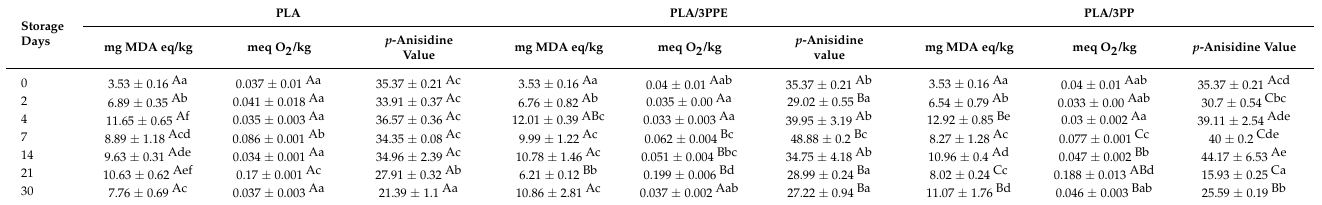
Table 7. Results of the TBARS assay, determination of the peroxide value, and the p -anisidine value of the almonds packaged with control and active PLA, stored at 40 ◦ C (accelerated assay).